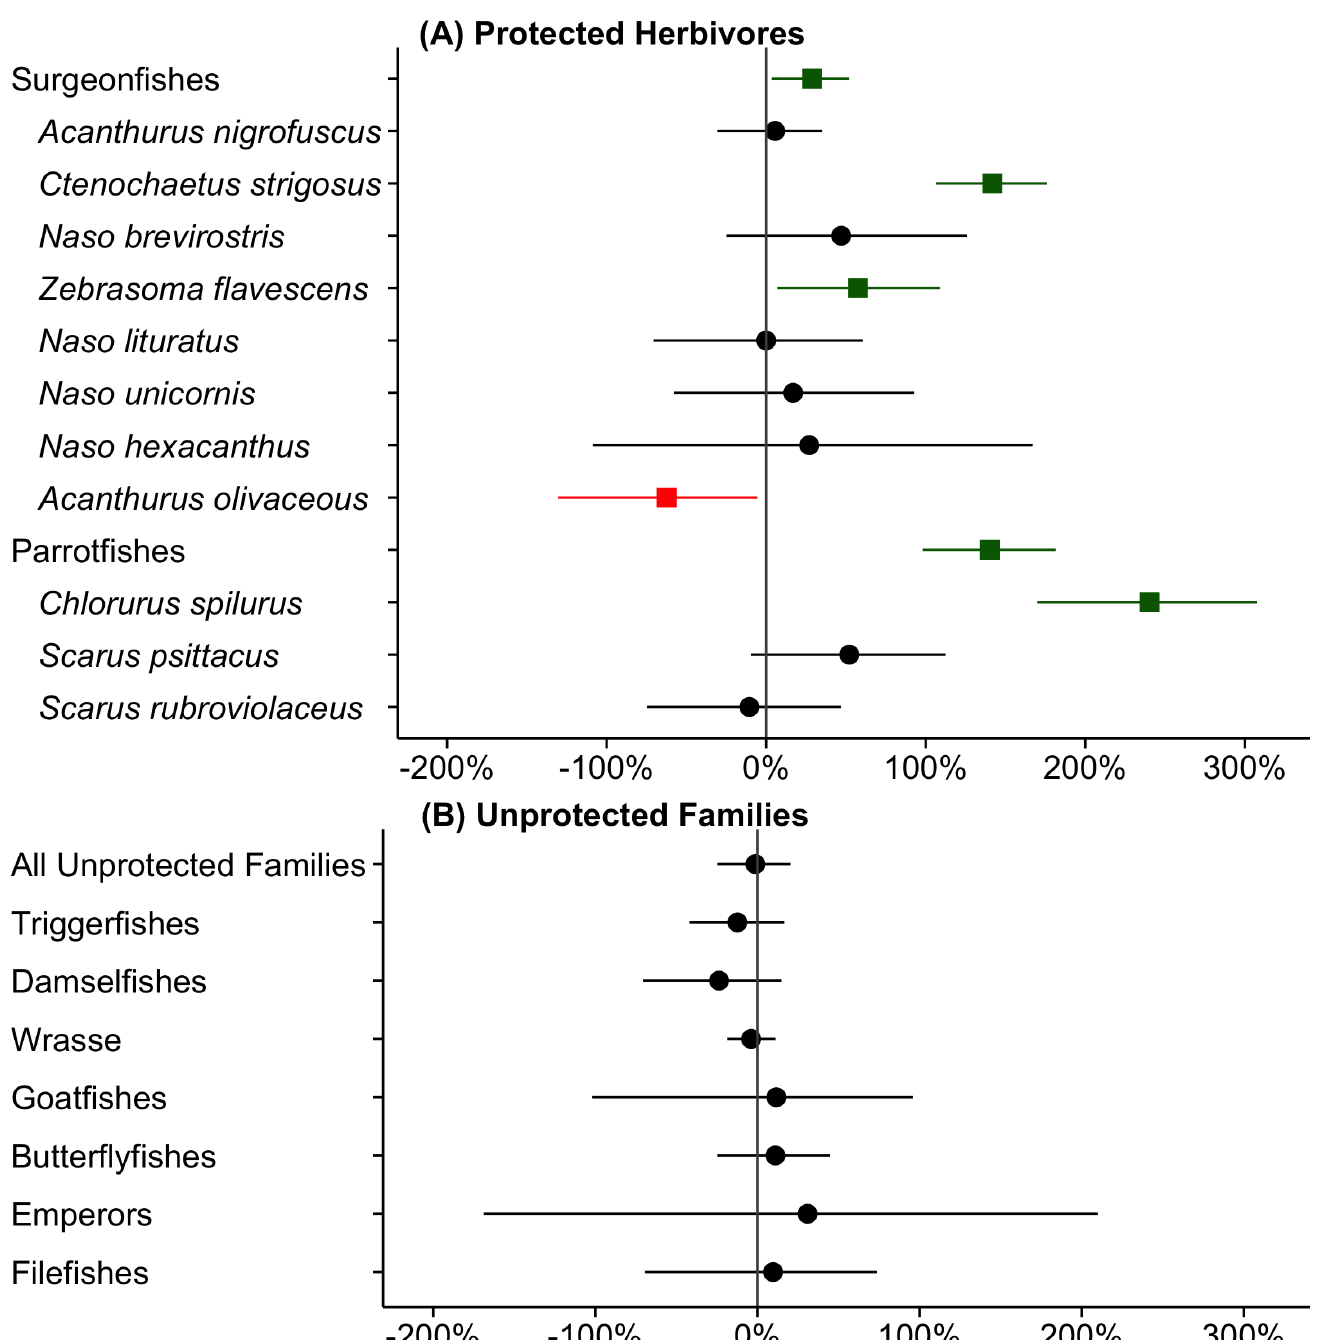
Fig 3. Net change between ‘ before ’ (2008 – 9) and ‘ after ’ (2014 – 15) by taxa for herbivores (protected from fishing) and other families (without fishery restriction). Data points represents the net proportional change in biomass from ‘ before ’ to ‘ after ’ , and lines present the 95% quantile range (95%QR) of that change. 95%QR not overlapping zero is evidence of a significant difference between time periods, shown as a green square (biomass increase) or red square (biomass decrease). Taxa shown are all those with mean biomass across before and after periods of at least 0.5 g/m 2 , plus a large bodied parrotfish species, Scarus rubroviolaceus , with mean biomass slightly below that level. Within groupings (surgeonfishes, parrotfishes, unprotected families), taxa are ordered by mean biomass from highest to lowest.